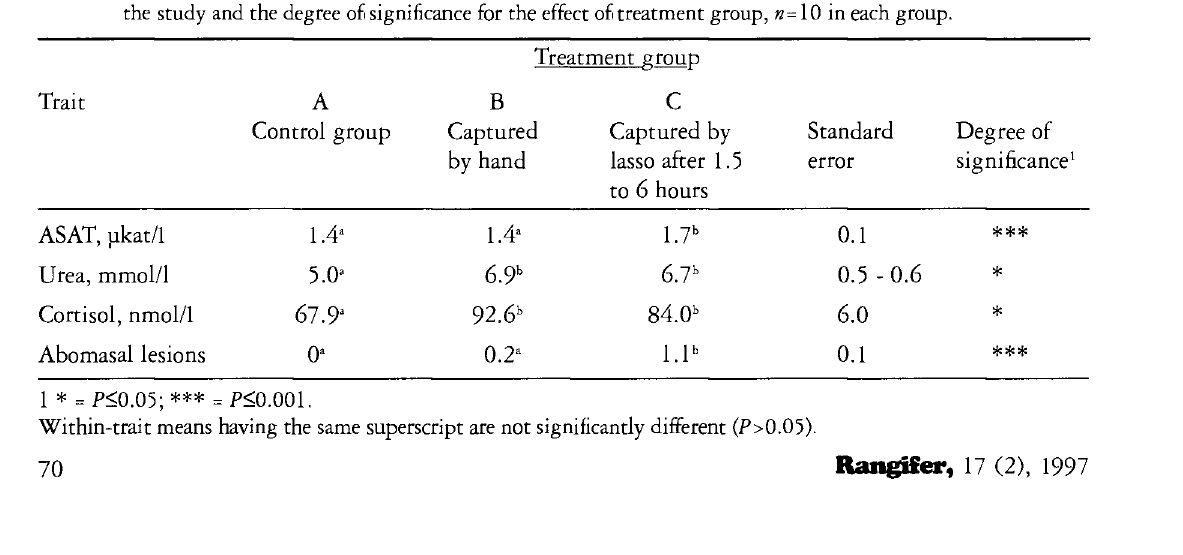
Table 4. Blood metabolites and abomasal lesions (least-squares means ± standard errors) in reindeer bulls included in the study and the degree of significance for the effect of treatment group, «=10 in each